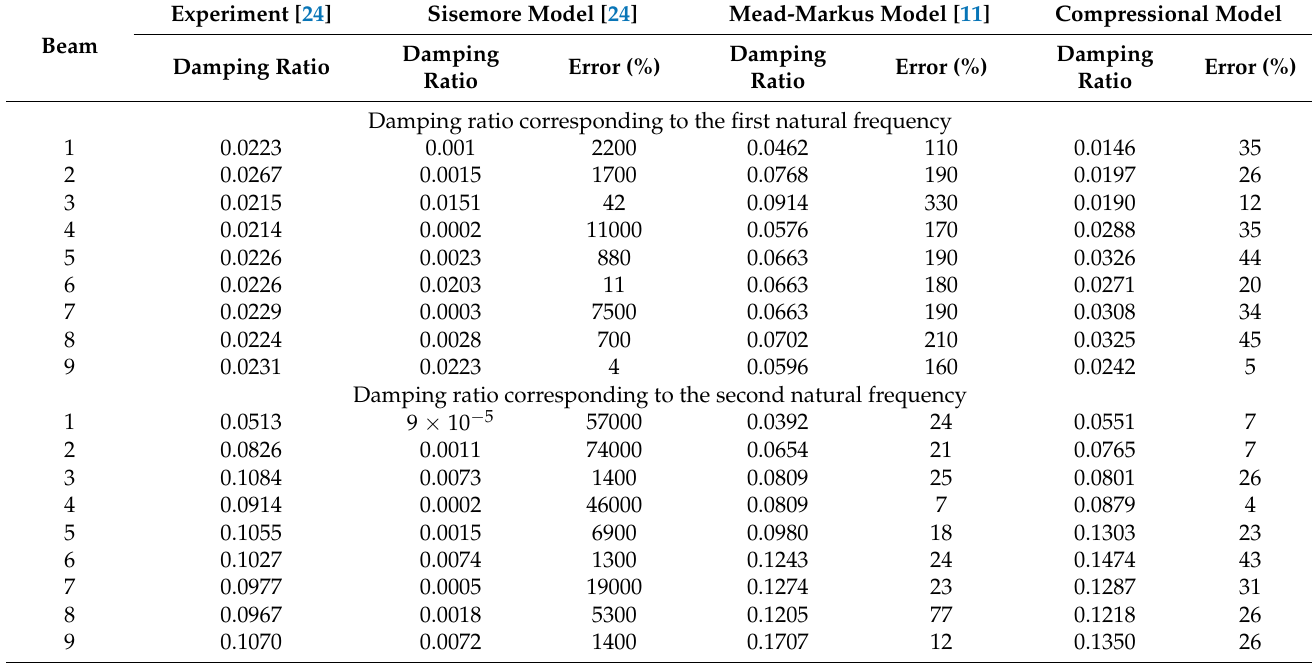
Table 7. Damping ratios of the first two modes for cantilever EVES beams: comparison of experimental and calculated results.